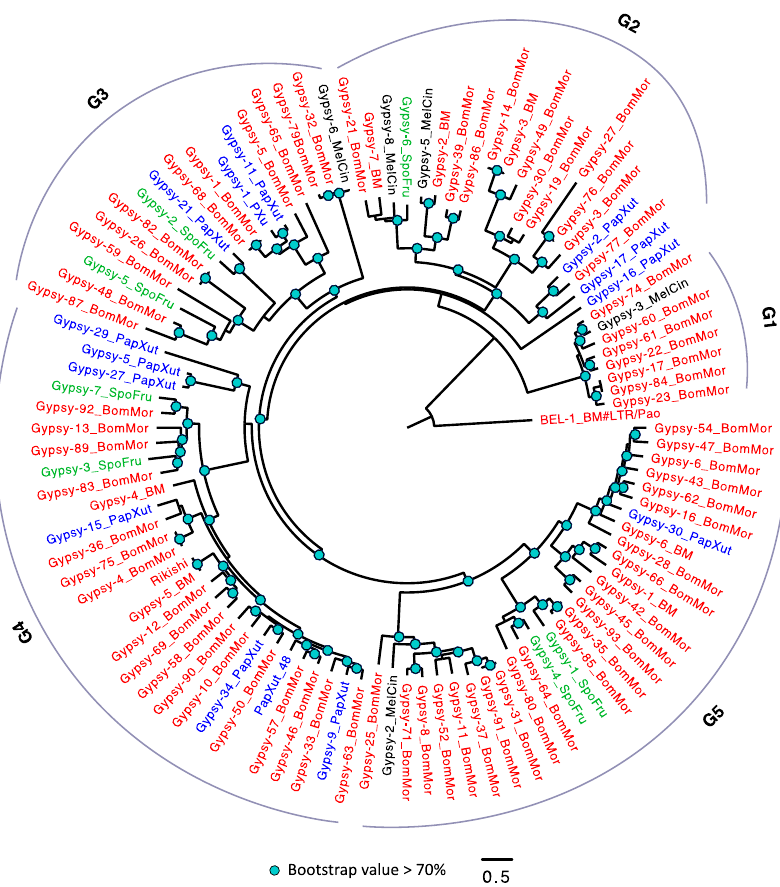
Figure 5. The phylogeny of Gypsy in Lepidoptera . The Gypsy were arbitrarily divided into five groups (G1–5). TEs with BM (annotated in Repbase) or BomMor (annotated in this study) suffixes are from B. mori (red name); TEs with PapXut, MelCin and SpoFru are from P. xuthus (blue name), M. cinxia (black name) and S. frugiperda (green name). Rikishi is from B. mori and has been annotated in BmTEdb [64]. Only nodes with bootstrap value not lower than 70% were indicated. BEL-1_BM is the outgroup.